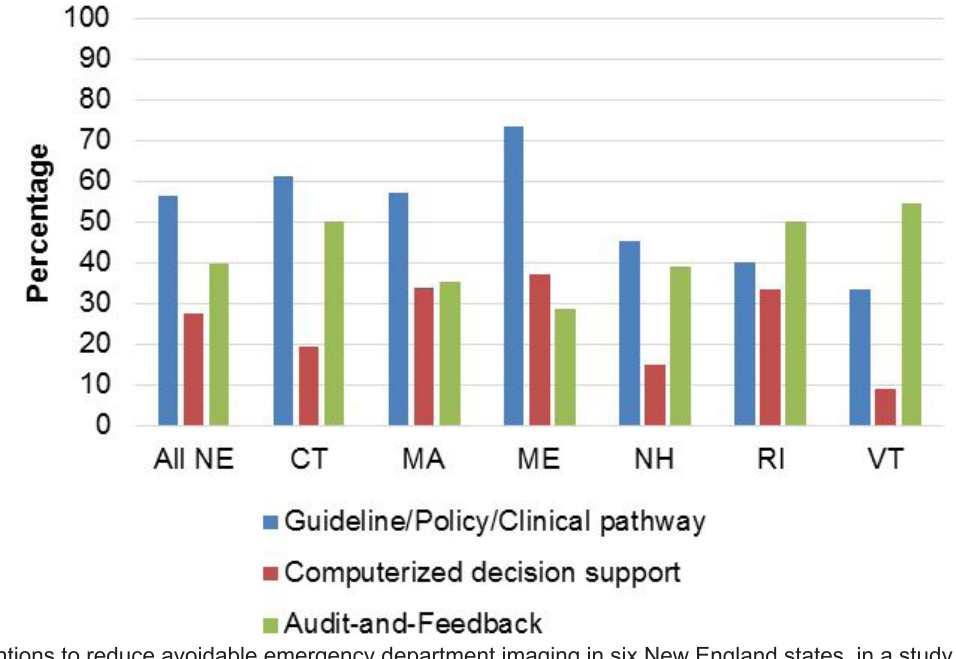
Figure 1. Interventions to reduce avoidable emergency department imaging in six New England states, in a study of the implementation of evidence-based Choosing Wisely